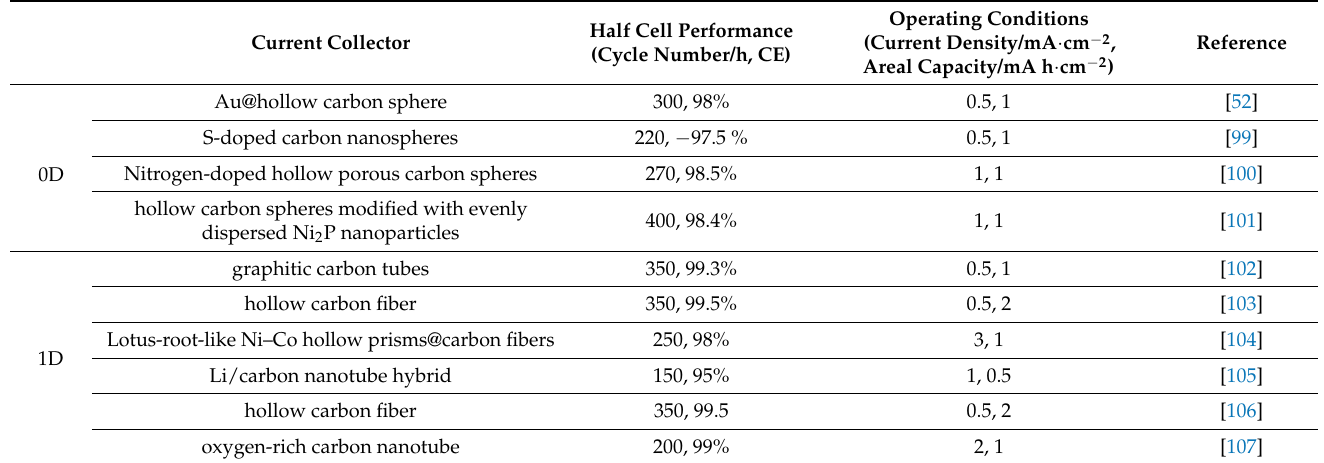
Table 1. Performance of lithium metal batteries using carbon materials as current